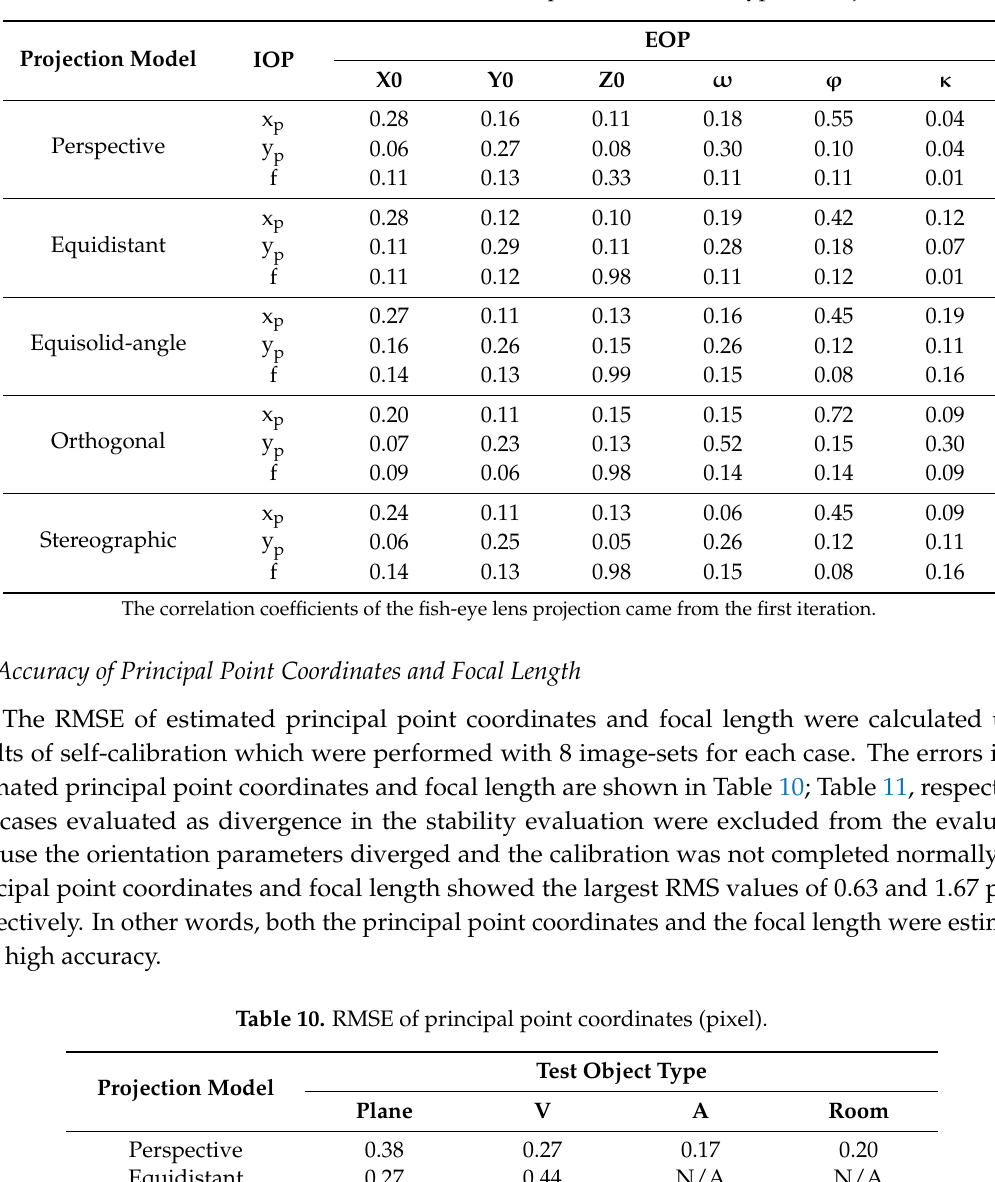
Table 9. Correlation between the orientation parameters (Room-type test object).